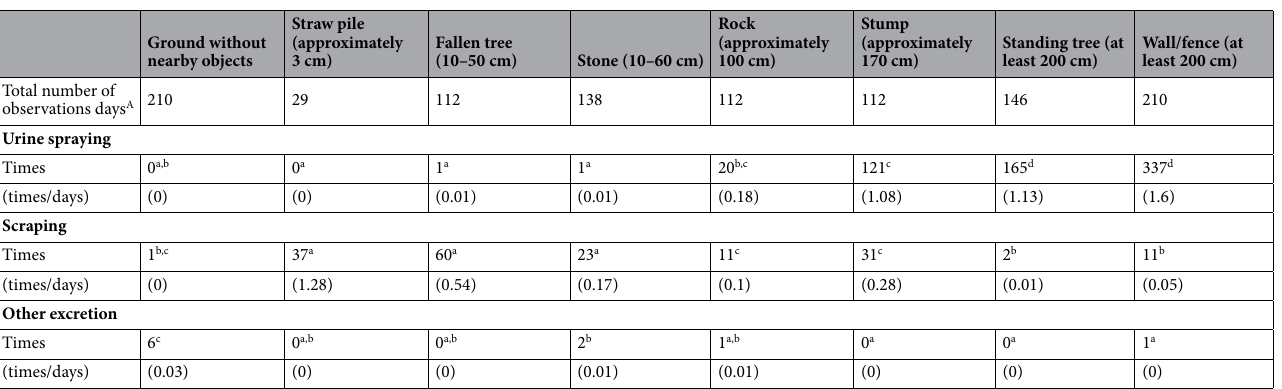
Table 6. Target location for urine spraying and scraping. A The “day” indicate the day individuals were monitored in the presence of the target object. The daily observation time is 25 min after release. a,b,c,d Each superscript represents a subset of the target object category whose ratio was not significantly different from the ratio of the subset of other categories (p < 0.05: χ 2 test).